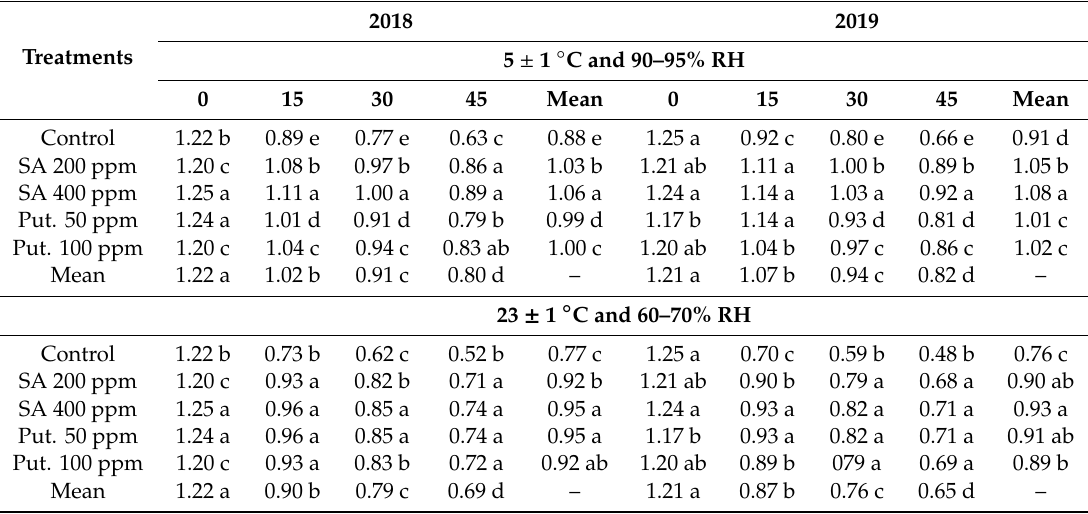
Table 5. E ff ect of salicylic acid (SA) and putrescine (Put) on acidity (%) of Murcott mandarin fruit at harvest and 15, 30, and 45 days of storage during 2018 and 2019 seasons.